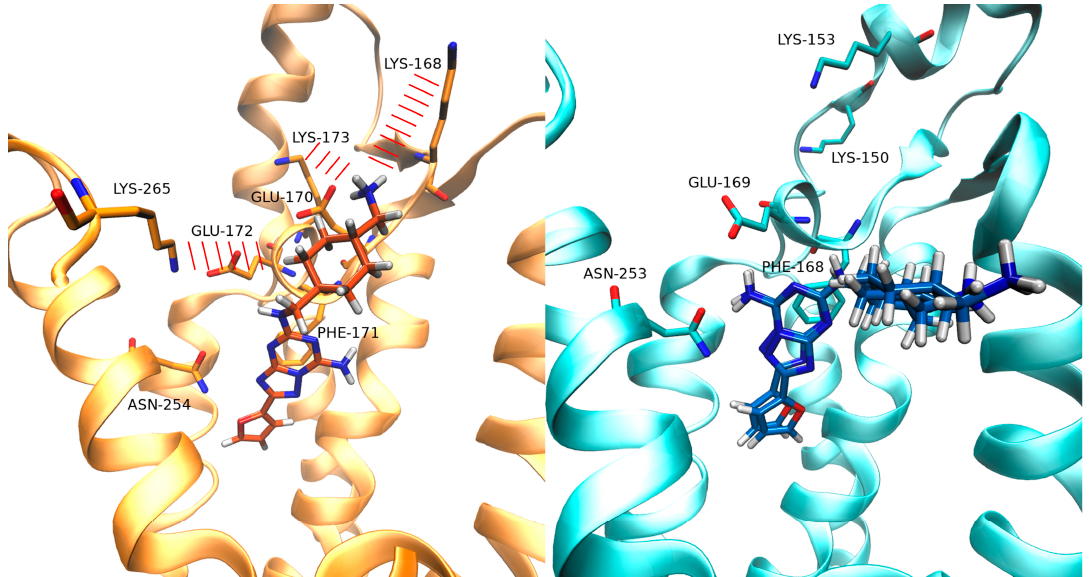
Figure 4. Binding mode of Z48 within the binding site of A 1 -AR on the left-hand side, and within the binding site of A 2A -AR on the right-hand side (superposition of the two simulations analyzed). For A 1 AR, the binding mode is reported at the end of the SuMD simulation. For A 2A AR, the two poses at the end of the classic MD simulation are reported.